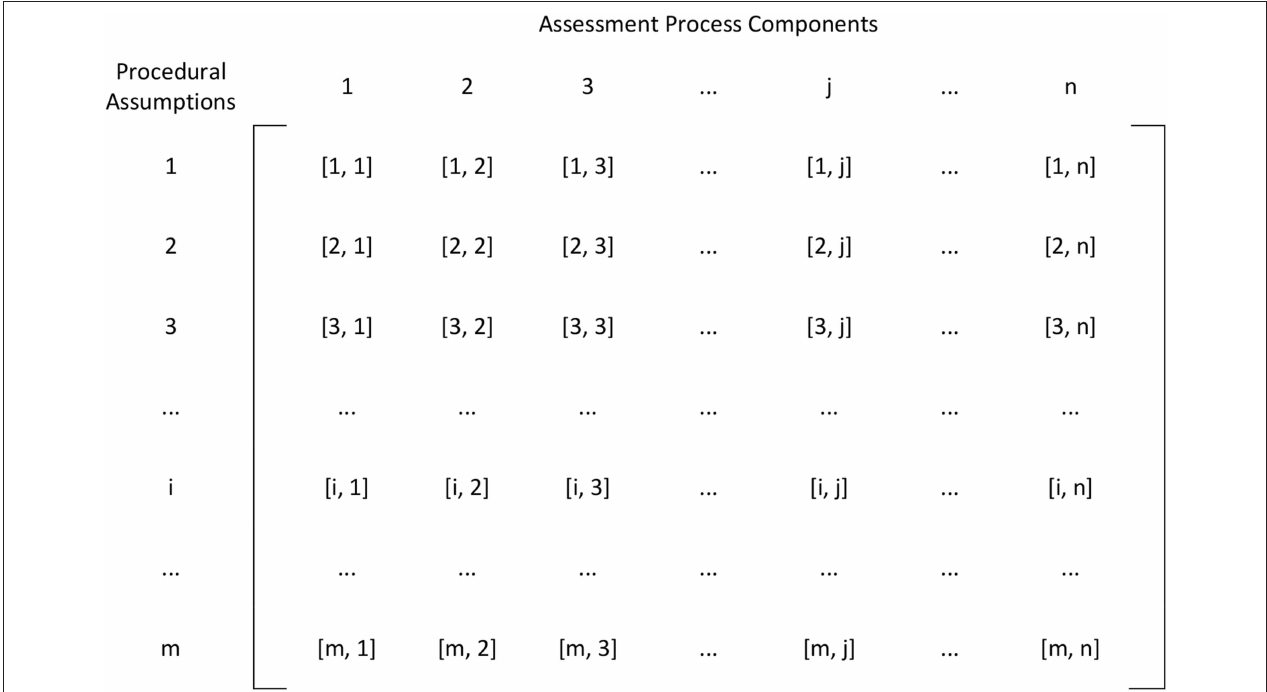
FIGURE 1 | Matrix of evidence for validity